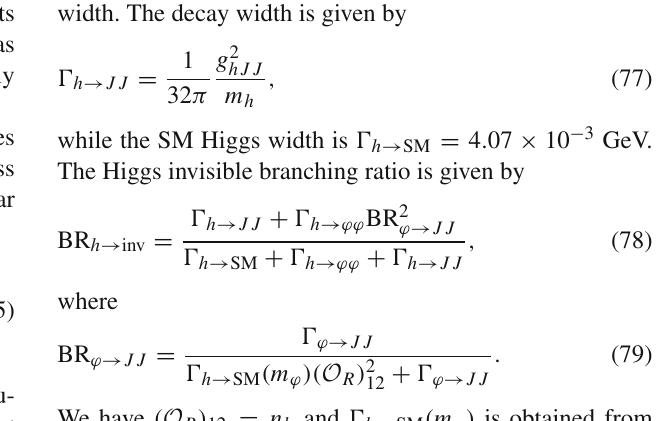
(not perturbative up to the Planck scale in the red dotted region) and the potential is not bounded from below in the yellow region. The blue region is forbidden by the mixing of the Higgs boson with the other